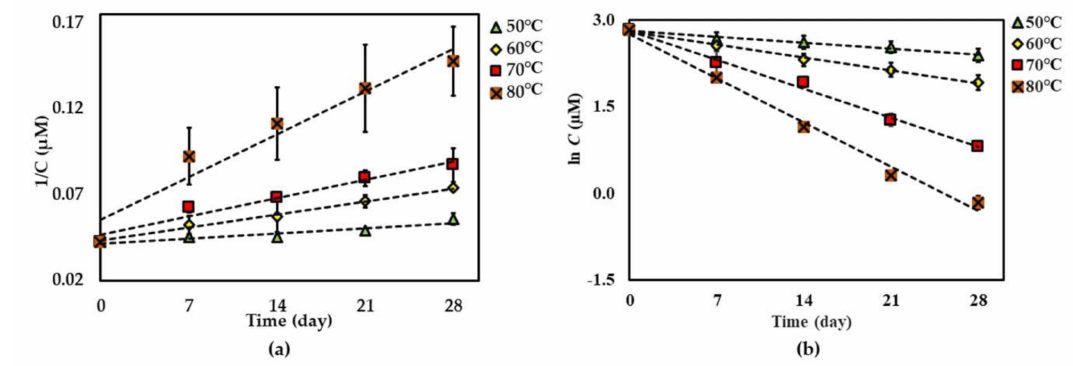
Figure 4. Thermal degradation kinetics for compound 3 at 50 ◦ C–80 ◦ C for 28 days in ( a ) dried AE (fitted to a second-order kinetic model) and ( b ) AE solution (fitted to a first-order kinetic model). The plotted points are mean ± SD ( n =